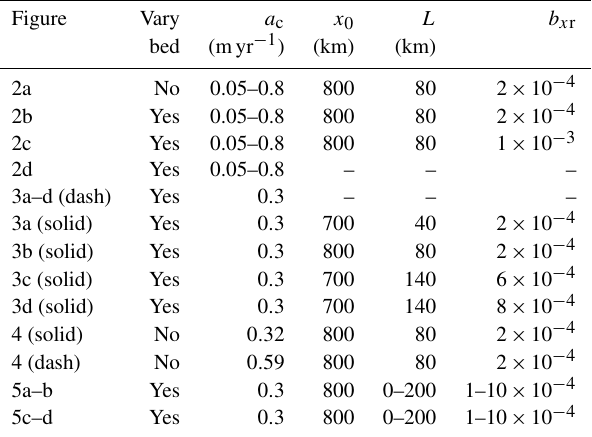
Table 2. Prescribed parameters and their variation in different sim- ulations listed by figure. Dashed entries indicates no retrograde sec- tion. A “yes” in the vary bed column indicates simulations in which bed properties are permitted to vary as a function of till water con- tent.